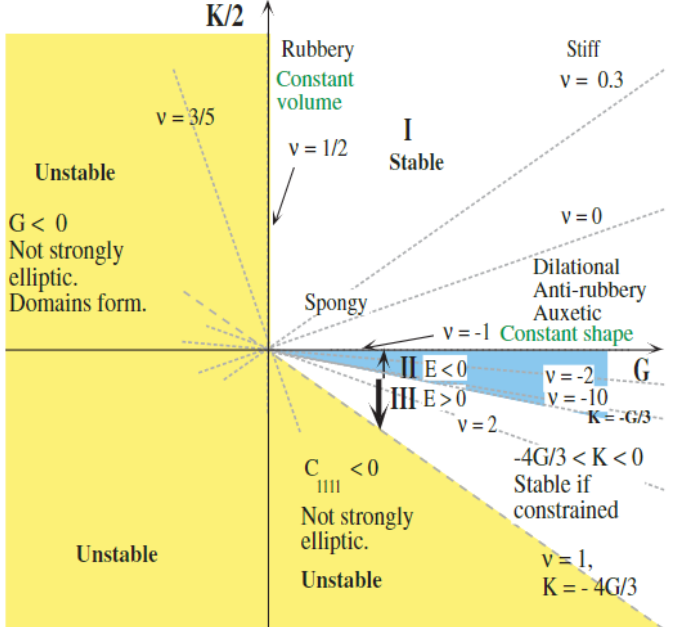
Figure 5. Map showing the elastic material properties corresponding to different values of K-modulus and shear modulus G. Reprinted with permission from Ref. [94]. Copyright 2007,